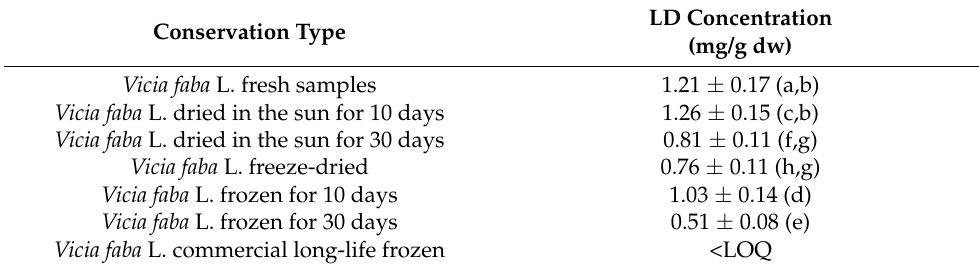
Table 2. LD quantification in seven Vicia faba L. broad beans, stored by different processes: fresh sample, 10-day sun-dried sample, 30-day sun-dried sample, freeze-dried sample, 10-day frozen sample, 30-day frozen sample, and commercial long-life frozen sample. LD content is expressed as (mg/g dw) ± U(mg/g). Values marked by the same letter are not significantly different ( p <